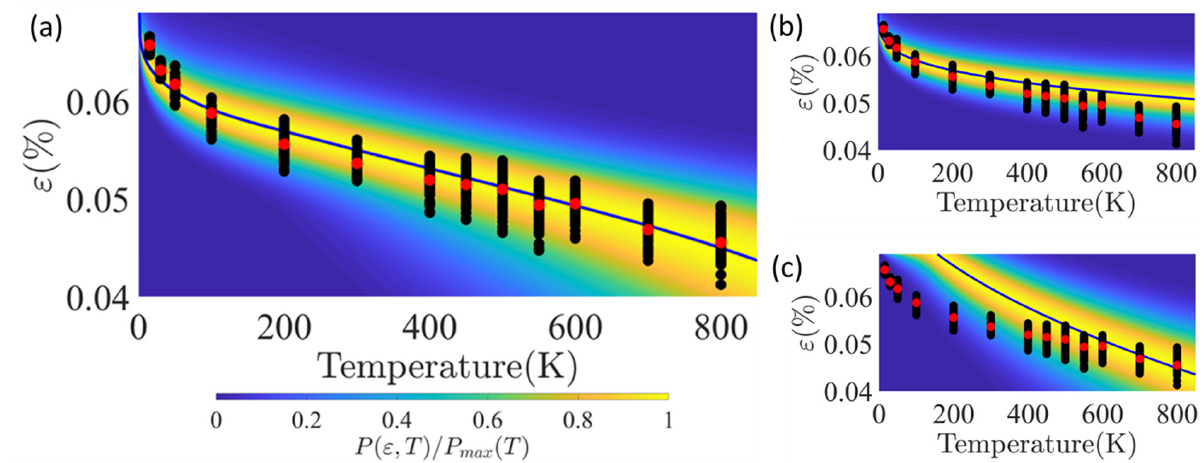
Figure 10. Analytical model for the probability distribution (PDF) for the strain to nucleate dislocation at a certain temperature when considering nucleation from ( a ) both site types, from the ( b ) acute angle and ( c ) the obtuse angle only. The color indicates the value of the PDF, scaled by its maximum value at each temperature. The most probable nucleation strain for each analytically calculated PDF is marked with blue line. All temperature-dependent nucleation strains calculated in the MD simulations are marked in black dots, and the most probable nucleation strain from the MD simulation ( ε ( T )) , is marked with red